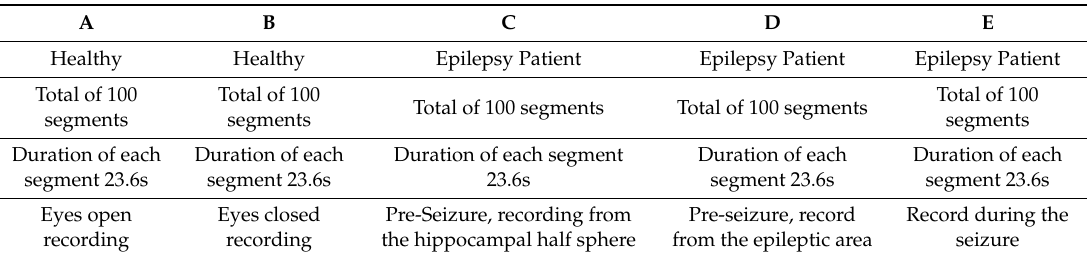
Table 1. Clusters and Properties of Electroencephalogram Datasets Used in the Study.